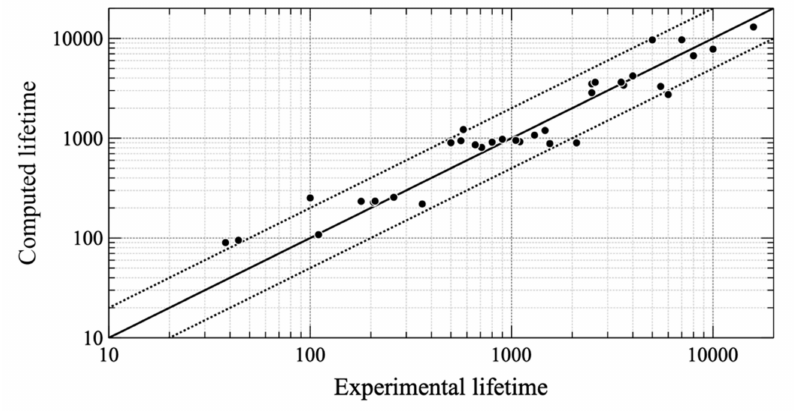
Figure 13. Computed lifetimes vs experimental lifetimes in number of cycles to failure for an AlSi7Cu3.5Mg0.1